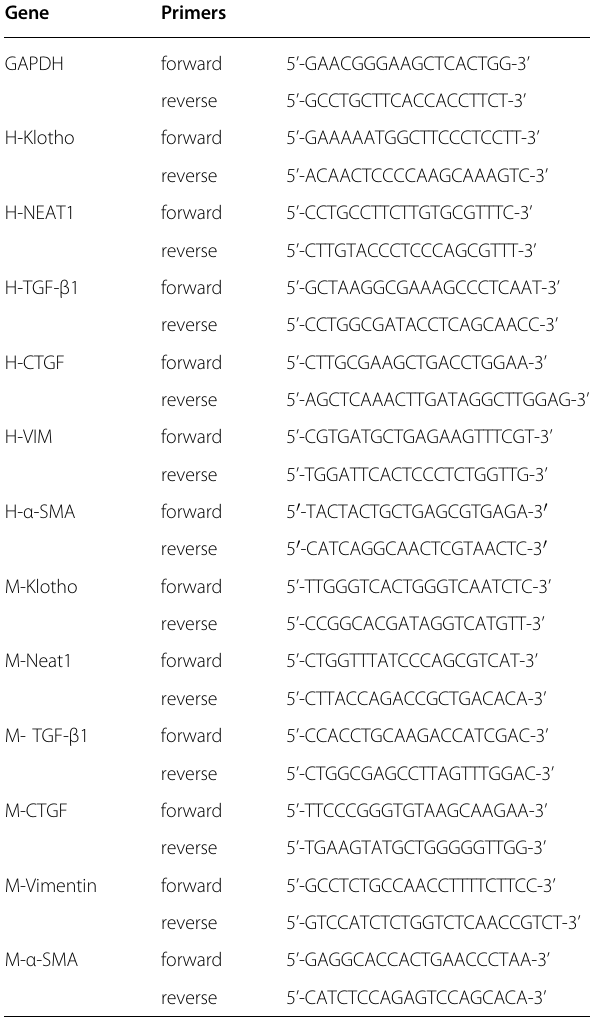
Table 2 Sequences of primers used for